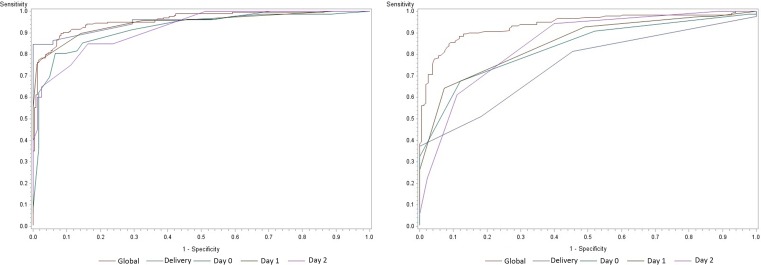
ROC (Receiver operating characteristics) curve analysis of the sequential diagnostic power of the two scores.The Curve analysis of each day: day of delivery (Delivery), Day 0, Day 1, Day 2 and curve analysis of the sum of all measured values (Global). The figure on the left represents the ROC curves of the new DIC score. The figure on the right represents the ROC curves of the ISTH score.